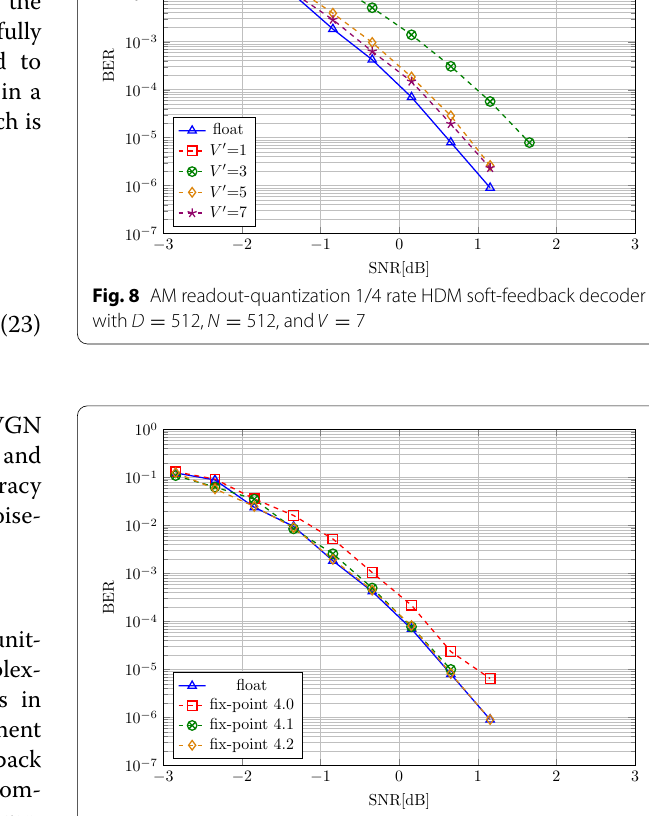
Fig. 9 Decoder quantization 1/4 rate HDM soft-feedback decoder with D = 512 , N = 512 , and V =